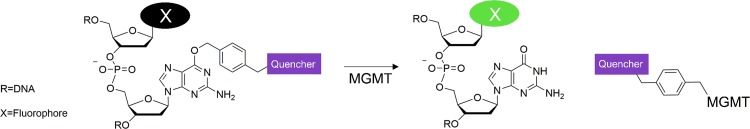
Design principle for a DNA-based chemosensor that reports on MGMT activity.A short modified DNA oligomer (see Table 1) contains an O6-benzylguanine nucleoside modified with a quencher dye. Fluorescence from a neighboring fluorophore (X) is initially quenched as a result of the proximity. When MGMT repairs the alkylated base, the benzyl-quencher group is transferred to the enzyme’s active site and fluorescence emission increases.